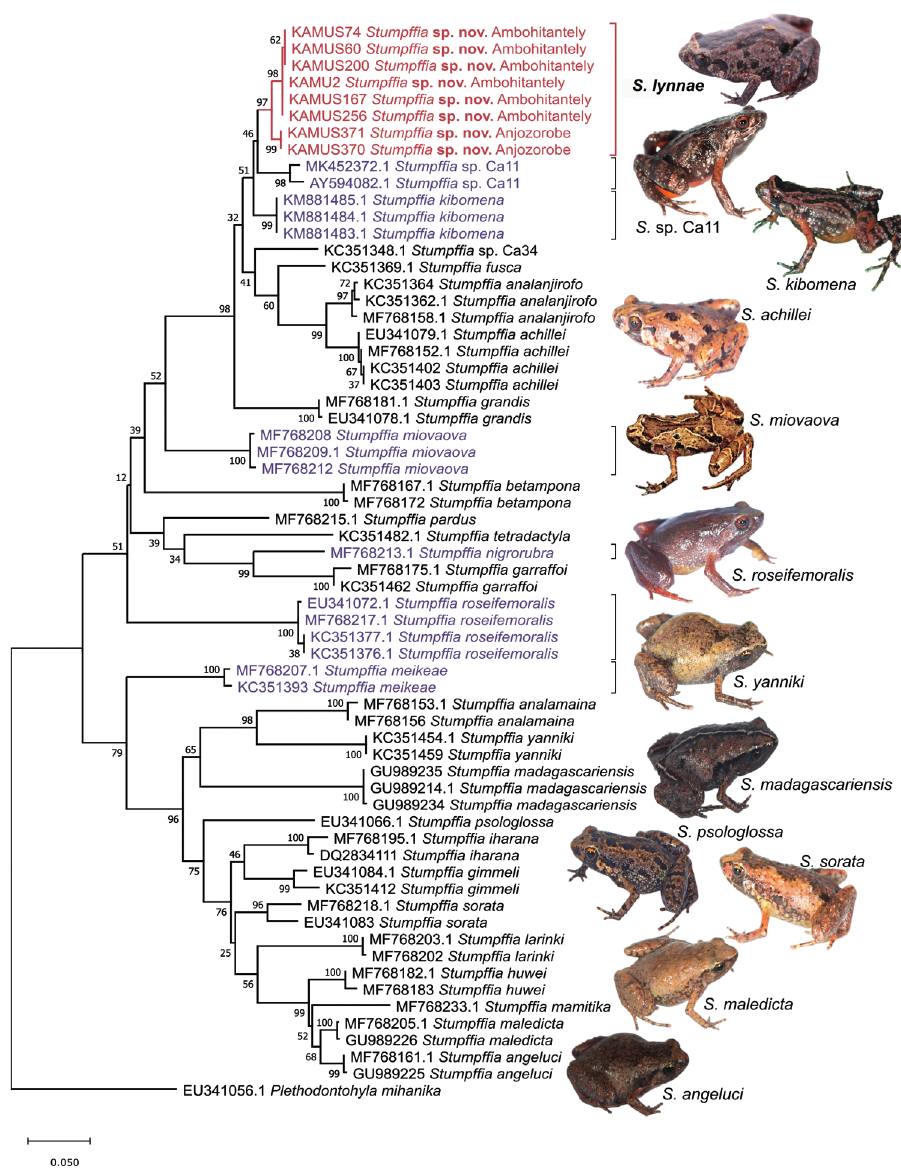
Figure 2. Maximum Likelihood tree of Stumpffia spp. based on analysis of a 621 bp fragment of the mi- tochondrial 16S rRNA gene. MUSCLE alignment, General Time Reversible model plus Gamma distribu- tion, all sites used, × 1000 bootstraps, SPR level 5, no variant sites. Purple labels mark the other red-bellied Stumpffia species. Photographs Mark D. Scherz and Frank